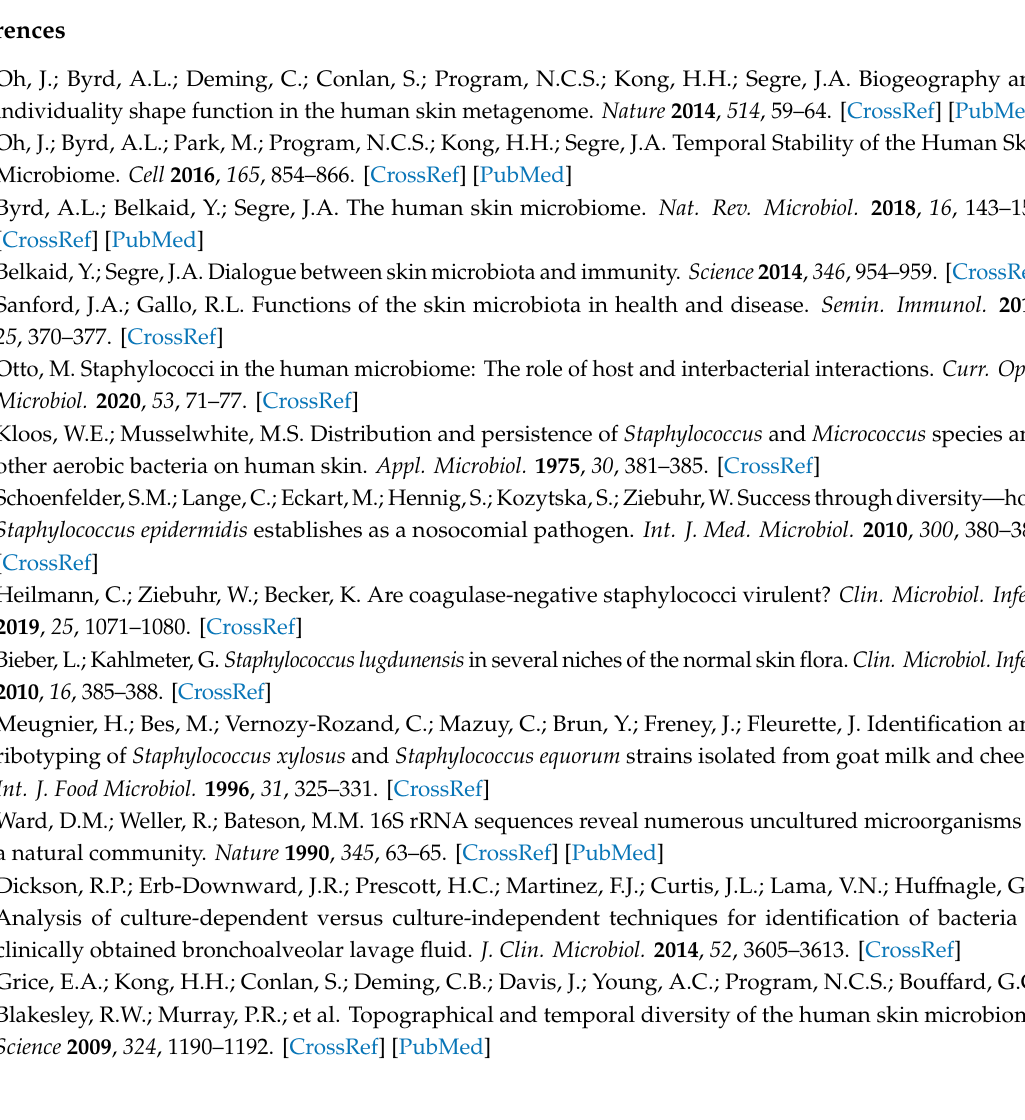
Table S1: Sequence read count matching the tuf gene fragment of di ff erent staphylococcal species; Table S2: Identification of sequencing reads in back skin metagenomic data that map to the hya gene of S. saccharolyticus with 100% nucleotide identity; Table S3: List of metagenomic datasets used for read